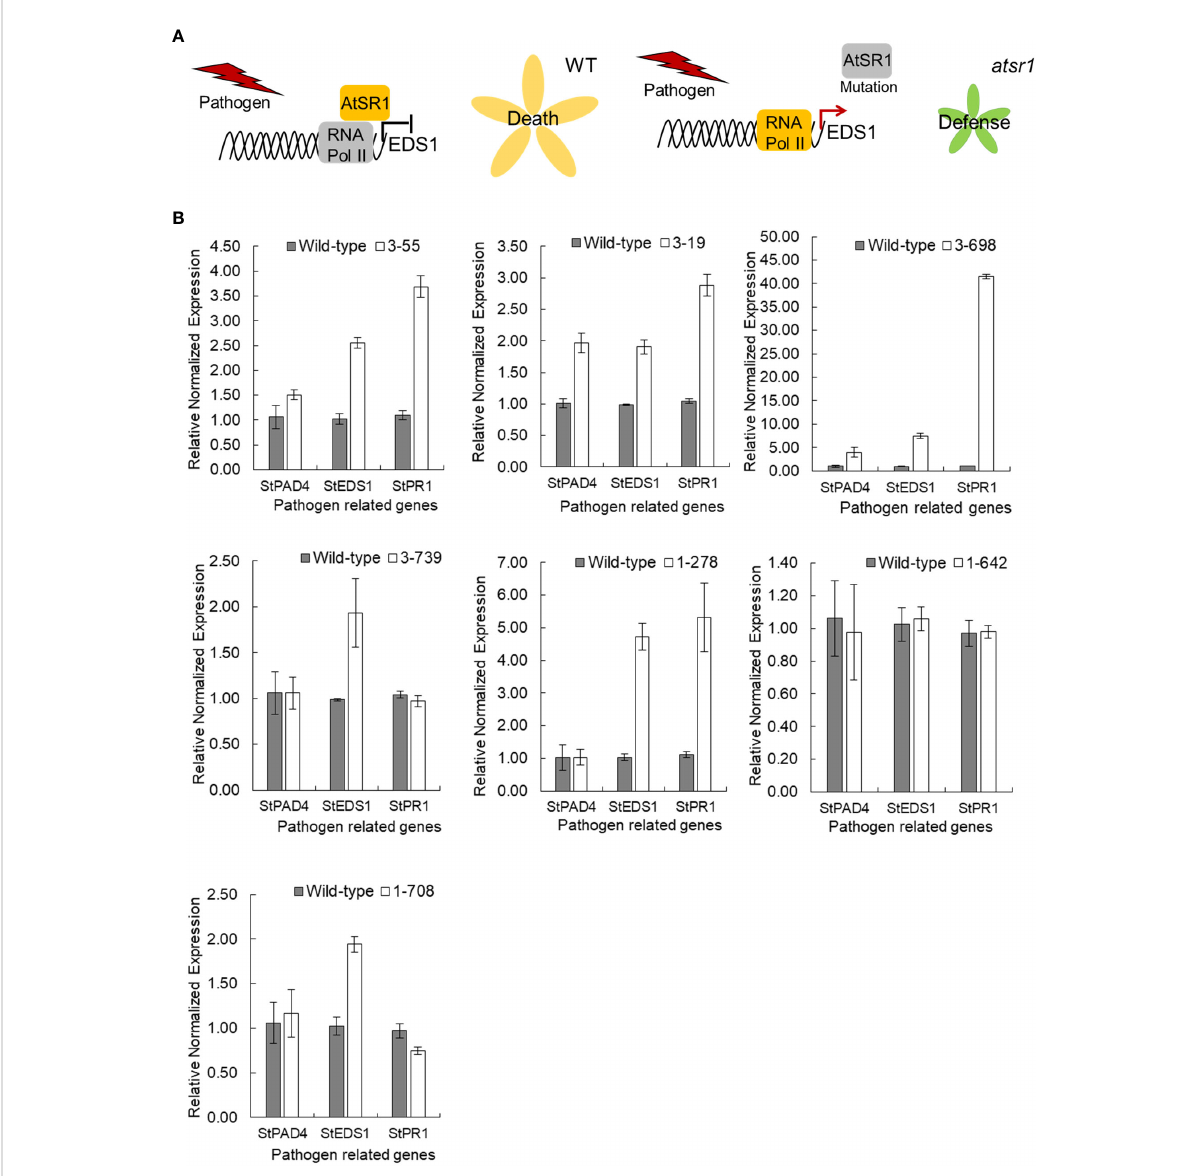
FIGURE 3 Transcript levels of StEDS1 , StPAD4 and StPR1 in stsr4 mutants. (A) A model demonstrating the function of AtSR1 as a negative regulator of pathogen resistance. (B) Analysis of mRNA expression of SA-related genes, StEDS1 , StPAD4 , and StPR1 , in stsr4